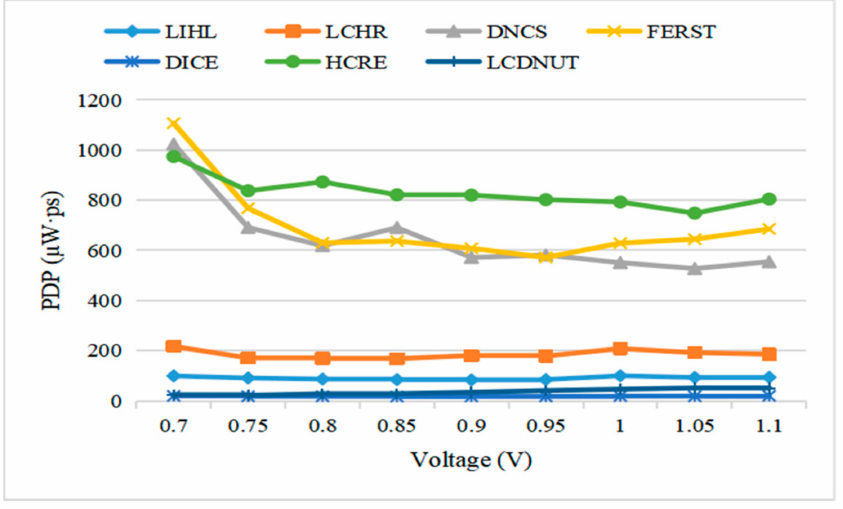
Figure 17. PDP of various latch designs under different voltages.